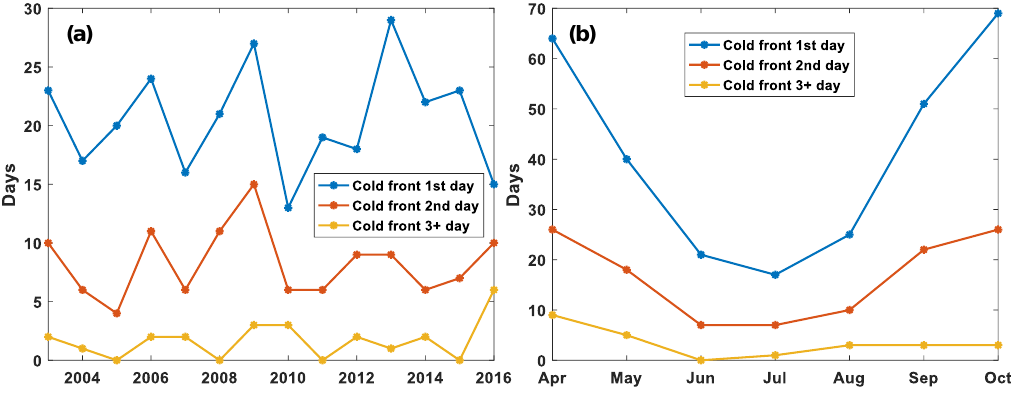
Figure 2. ( a ) Annual and ( b ) monthly time series of cold front